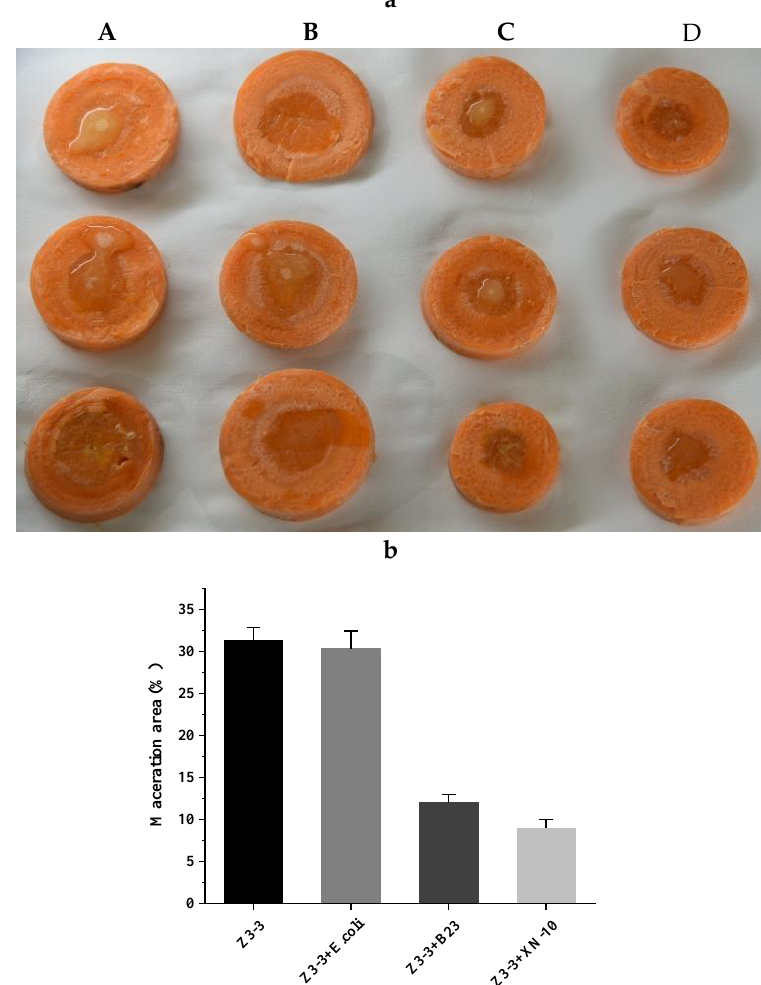
Figure 7. Biocontrol test of strain XN-10 against Pectobacterium carotovorum subsp. carotovorum ( Pcc ) on carrot slices under laboratory conditions. ( a ) Attenuated maceration of Pcc strain Z3-3 by strain XN-10 on carrots. A: inoculation of Z3-3 alone; B: co-inoculation of Z3-3 and Escherichia coli DH5α; C: co-inoculation of Z3-3 and Bacillus thuringiensis subsp. israelensis B23; and D: co-inoculation of Z3-3 and strain XN-10. ( b ) Tissue maceration rates in each treatment.